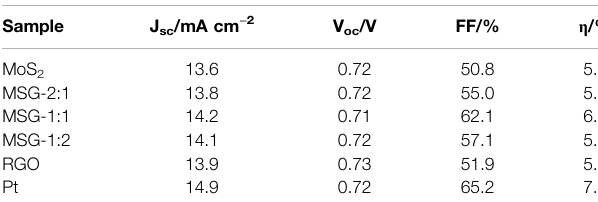
TABLE 1 | Photovoltaic parameters of the cells with MSG-2:1, MSG-1:1, MSG-1: 2, RGO, MoS 2 , and Pt counter